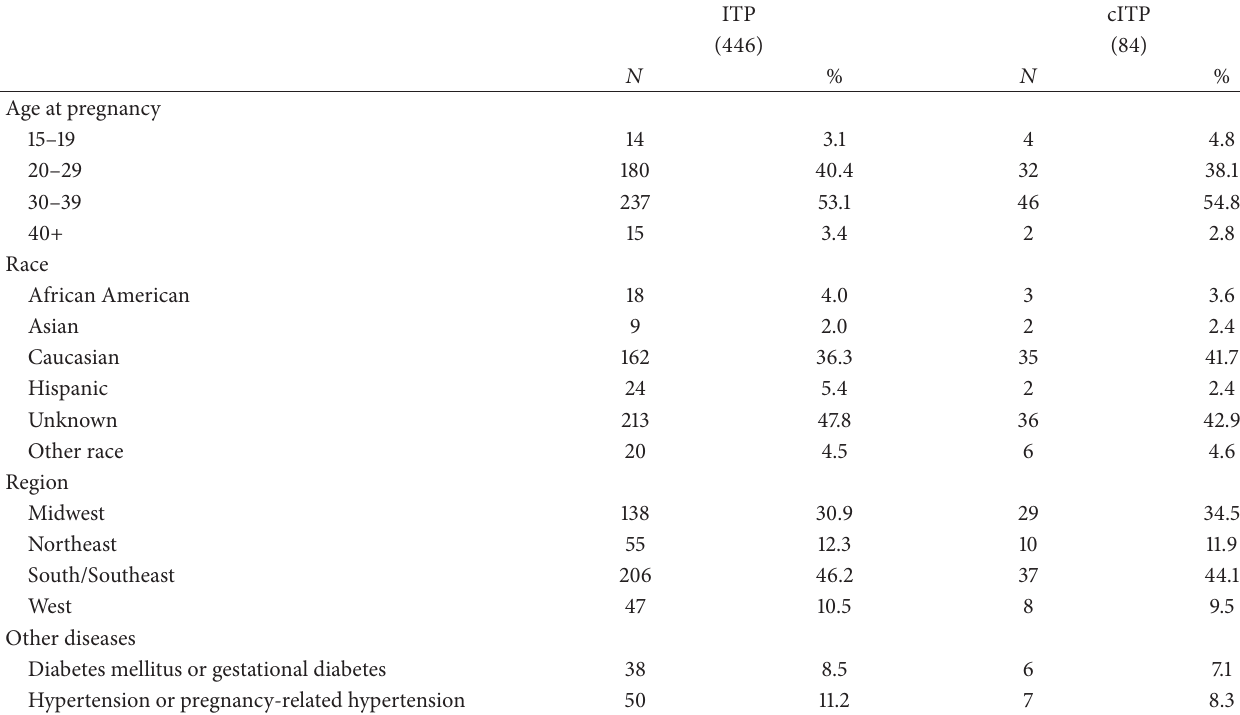
Table 1: Demographic characteristics of women with ITP and cITP.